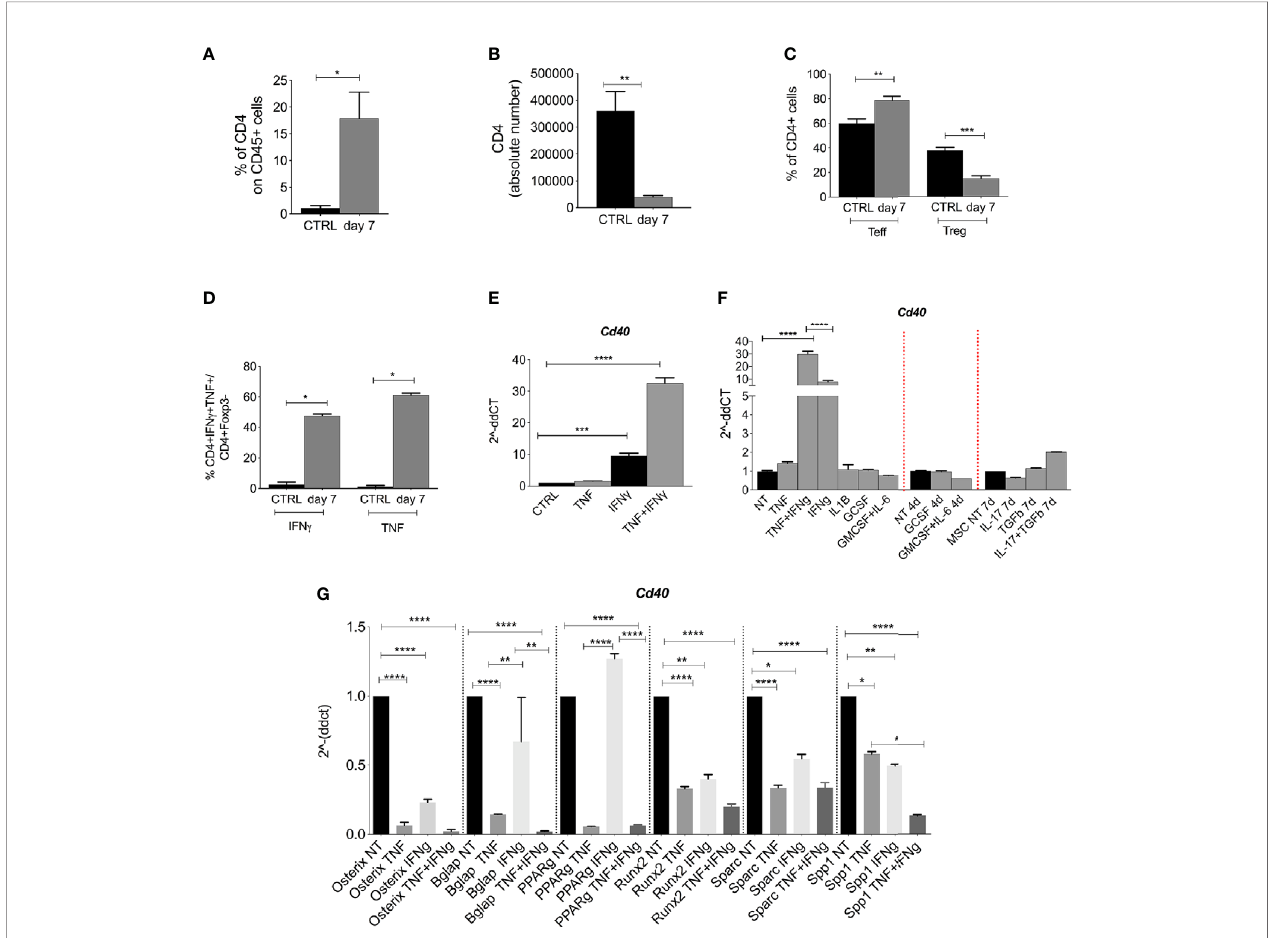
FIGURE 3 | CD40 expression is induced by pro-in fl ammatory cytokines. (A) FACS analysis showing the frequency of CD4+ within the CD45 cells in lethally irradiated (not reconstituted) or naive mice (n = 4 per group). *p < 0.05, Mann-Whitney test. (B) Absolute number of CD4+ cells within the BM of irradiated (not reconstituted) or naive mice. (n = 4 per group, *p < 0.05, Mann-Whitney test). (C) Frequency of Teffs (CD25-Foxp3 − ) and Tregs (CD25+Foxp3+) in irradiated mice (CD4 gate) (n = 4 per group). **p < 0.005, ***p < 0.001, compared according to unpaired t test. (D) FACS analysis showing the frequency of Teffs producing IFN g and TNF (CD4+Foxp3 − gate) (n = 4 per group). **p < 0.005, ***p < 0.001, compared according to unpaired t test. (E) Semi-quantitative qPCR analysis showing Cd40 expression on BM-MSCs at 24 h post TNF and IFNg stimulation. ***p < 0.001, ****p <0.0001. (n=3/group, One-way ANOVA, Tukey ’ s multiple comparison). (F) RT-PCR analysis for CD40 expression in BM-MSCs ( ex vivo isolated and in vitro expanded) treated in vitro with IL-1b, G-CSF, GM-CSF+IL-6, IL-17, and TGF-b. (****p <0.0001, One-way ANOVA, Tukey ’ s multiple comparison). (G) TNF and IFNg stimulation of BM-MSC alters the differentiation program toward osteo-and adipo- lineages. RT-PCR analyses showed that after 24 h, the treatment with 10 ng/ml IFNg and 50 ng/ml TNFa decreased the expression of osteoblast and adipocytes differentiation markers on BM-MSC compared to levels on untreated cells. The combination of TNF and IFNg was additive in decreasing the expression of Spp1 (*p < 0.05, **p < 0.005, ****p < 0.0001, One-way ANOVA, Tukey ’ s multiple